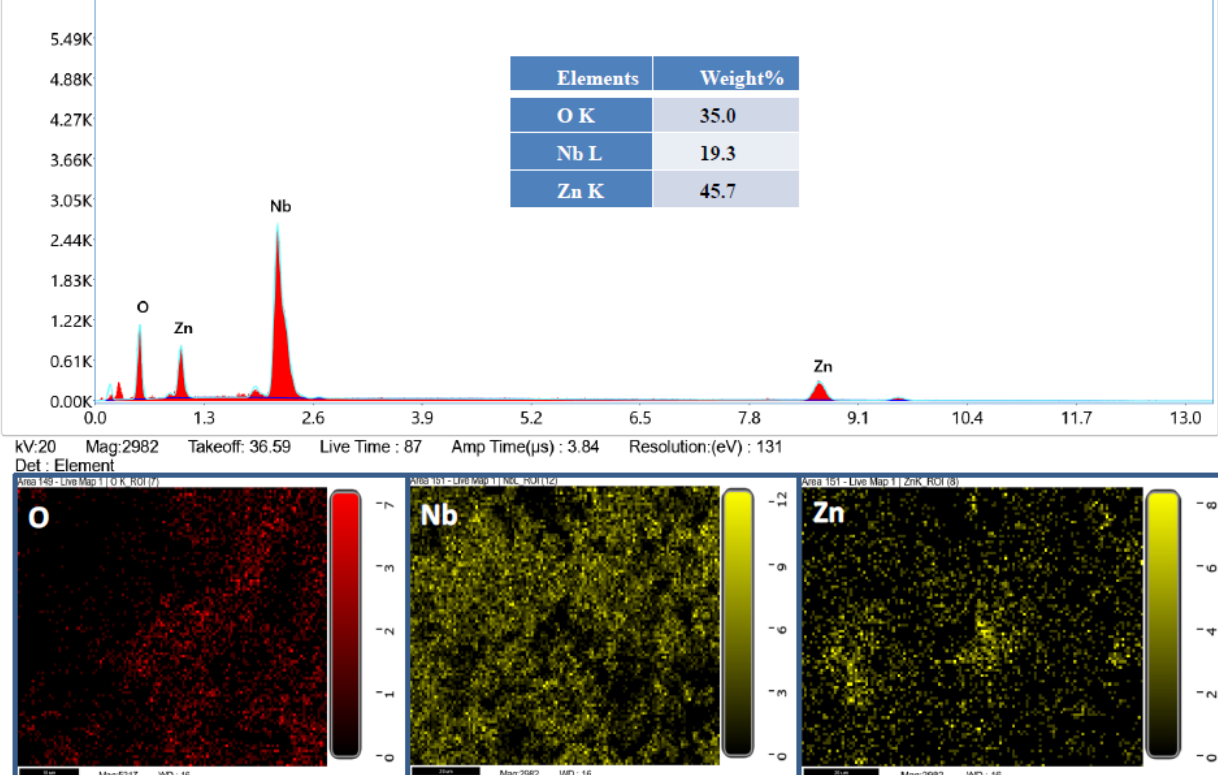
Figure 2. EDX spectrum and EDX mapping of β -Nb 2 ZnO 6 nanoparticles ( A ). Zeta potential is an imperative technique for determining the surface charge and stability of nanoparticles and can tell us the state of nanoparticle surface nature. The zeta potential of β -Nb 2 ZnO 6 nanoparticles ( A and B ) is shown in Figure 3; both β -Nb 2 ZnO 6 nanoparticles ( A and B ) have a less variation in the zeta potential and it was observed at − 12.9 and − 13 mV, respectively, while the polydispersity index (PDI) of β -Nb 2 ZnO 6 nanoparticles ( B ) (PDI: 0.518) was slightly decreased as compared to β -Nb 2 ZnO 6 nanoparticles ( A ) (PDI: 0.690). Similarly, the particle size distribution of β -Nb 2 ZnO 6 nanoparticles ( A and B ) was observed at 517 and 453 nm, respectively. Results indicated almost similar stability of β -Nb 2 ZnO 6 nanoparticles ( A and B ) in the deionized water.